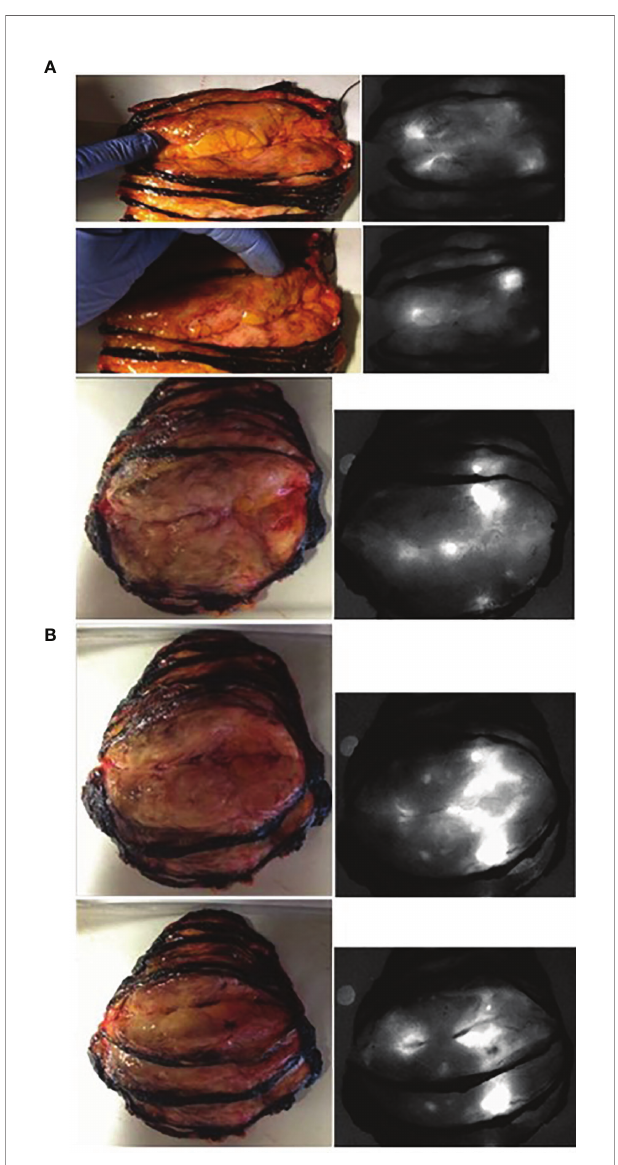
FIGURE 1 | Normal and fl uorescent images of the freshly sliced specimen from patient n° 20 in group 2 (panel A : the two ductal lesions — shown by the author ’ s fi nger — are fl uorescent: the smallest was only 3 mm large) and from patient n° 19 in group 2 (panel B : with one lobular